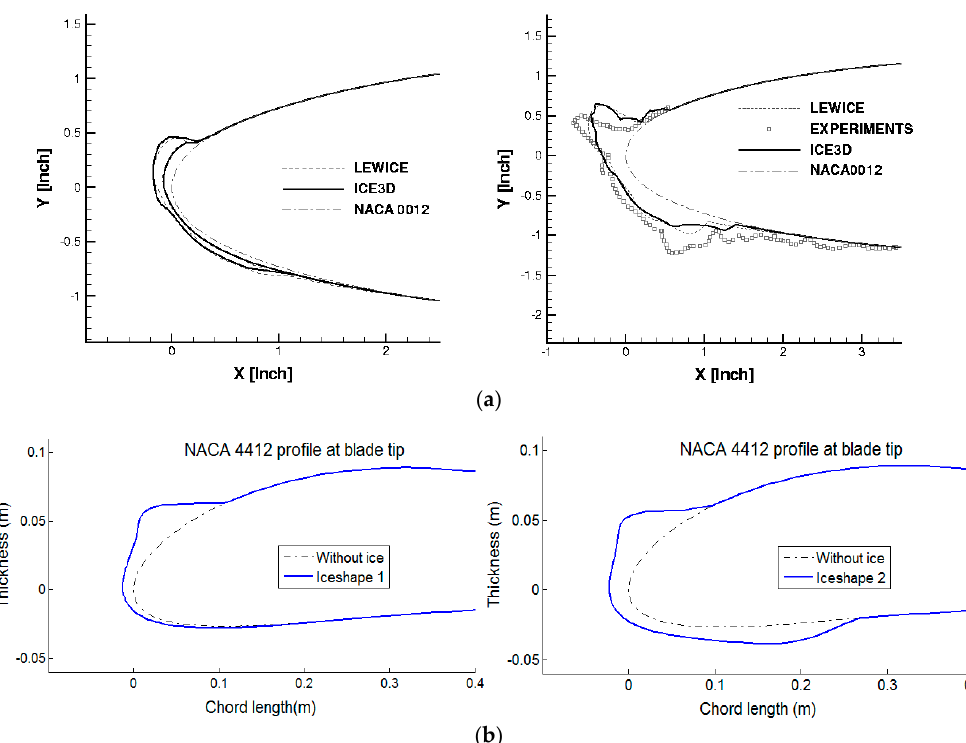
Figure 4. ( a ) Ice shapes predicted in [11]; and ( b ) Ice shapes replicated using discrete Fourier sine series. (The left figure refers to Ice shape 1 and right figure refers to Ice shape 2).